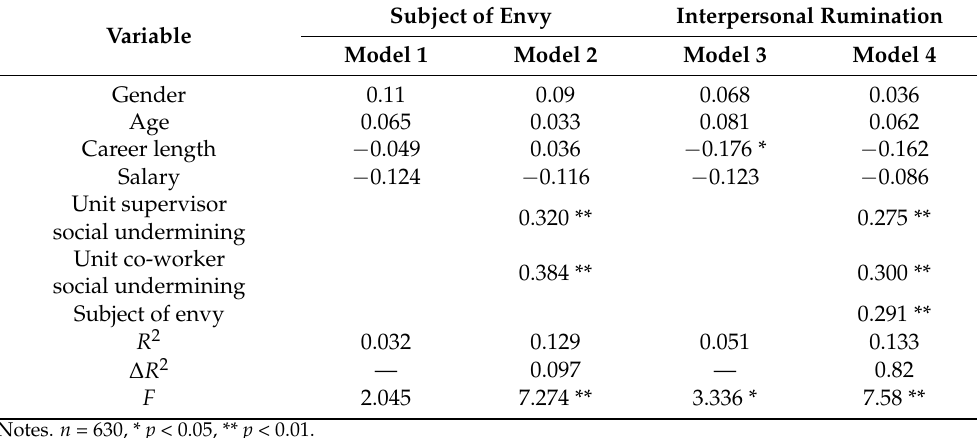
Table 5. Hierarchical regression analysis results.